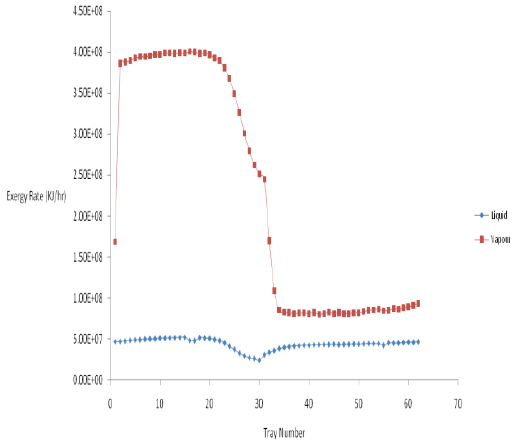
Figure 16. Profile of exergy rate versus tray number for Depropanizer of base case, 30 o C, Reflux Ratio